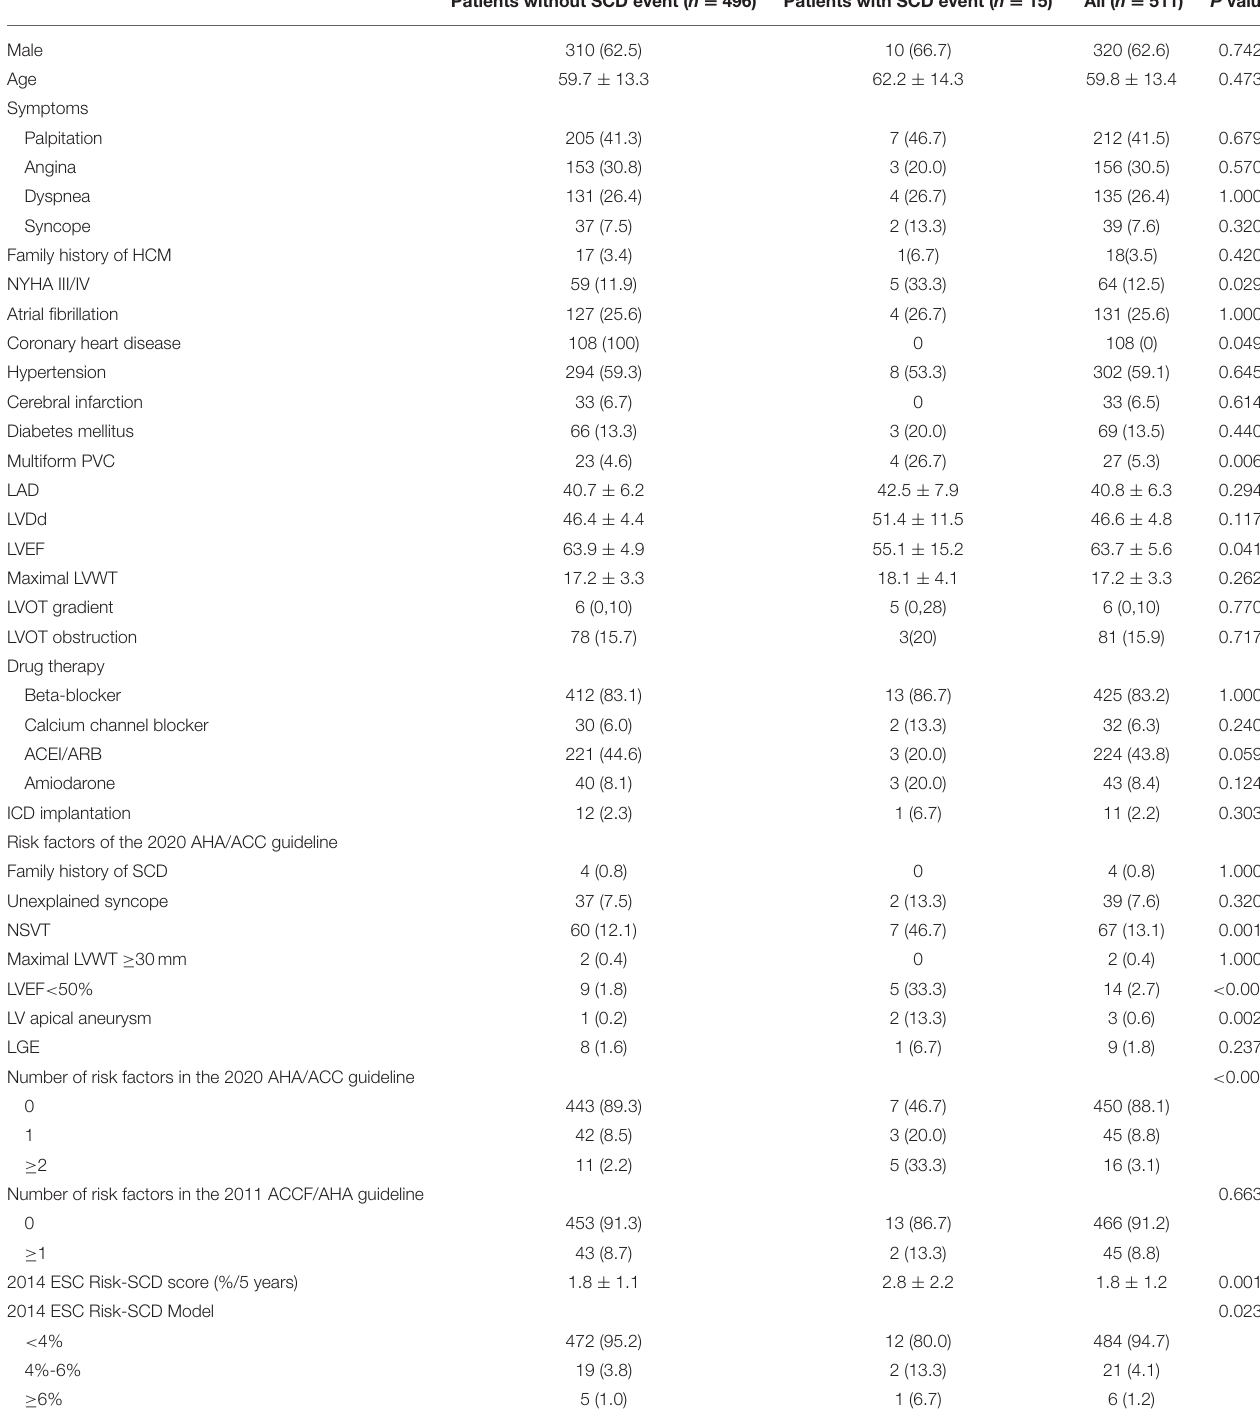
TABLE 1 | Baseline clinical characteristics of the 511 HCM patients. Patients without SCD event ( n = 496) Patients with SCD event ( n =